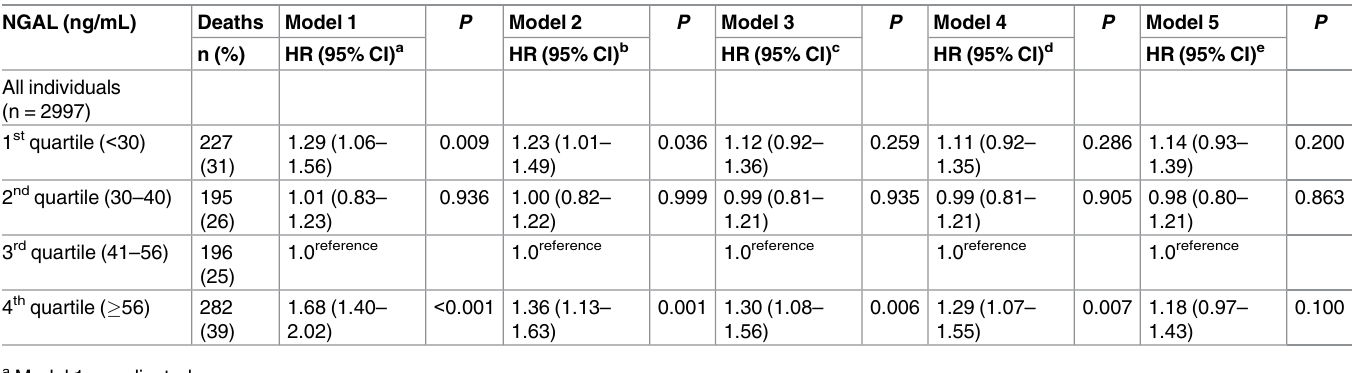
Table 3. Hazard ratios (HR) for death from all causes according to NGAL.